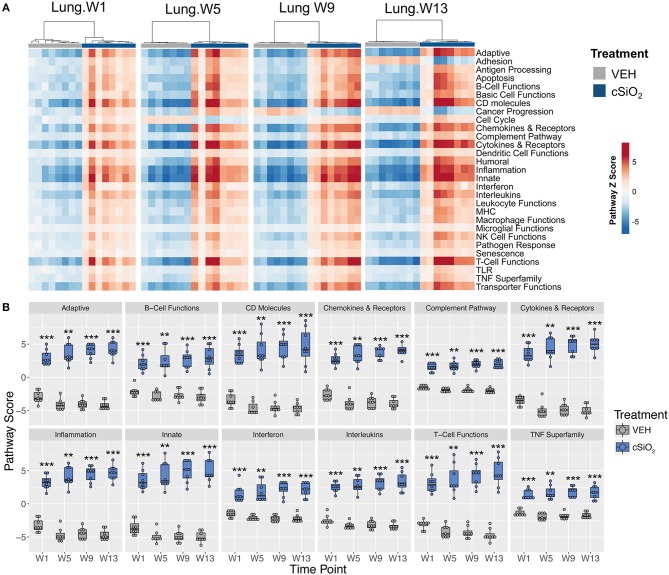
Lung tissue gene expression pathway Z scores at 1, 5, 9, or 13 weeks post cSiO2 instillation. (A) Heatmap depicts individual pathway Z scores of each immune pathway for lung tissues obtained from mice 1, 5, 9, or 13 weeks post instillation with cSiO2 (four weekly doses) or time-matched vehicle (VEH) controls. (B) Pathway Z scores are presented as Tukey box-plots (n = 7–8) for select immune pathways of interest. **p < 0.01; and ***p < 0.001 compared to time-matched vehicle control as determined by the non-parametric Wilcoxon test.